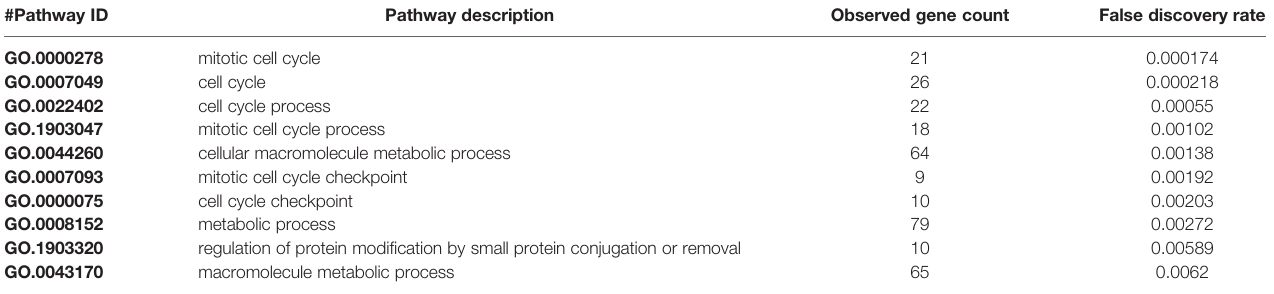
TABLE 2 | Process annotation of 138 differentially expressed